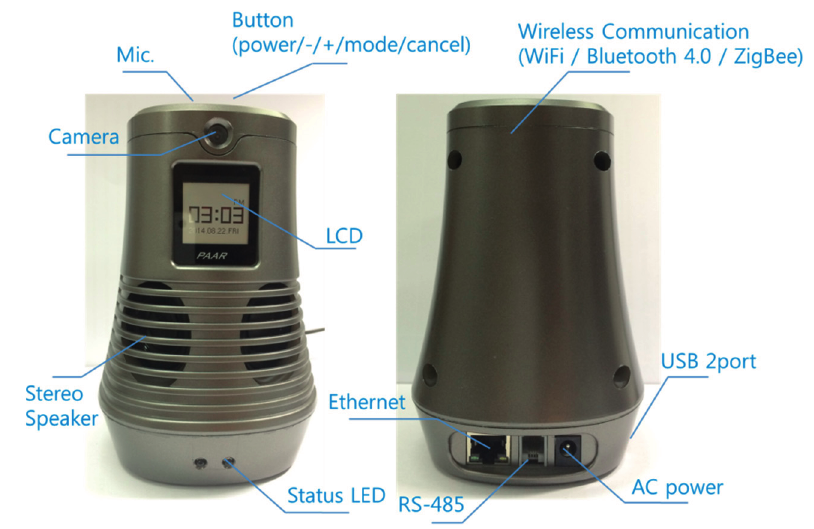
Figure 18. The SLiM Hub hardware with its various wireless and wired communication